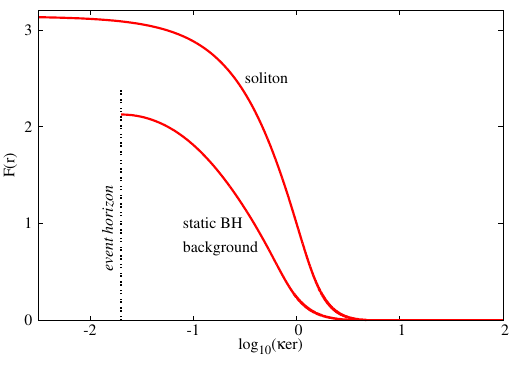
Figure 1 . The pro(cid:12)le of the Skyrme function, F ( r ), for the fundamental Minkowski and Schwarzschild Skyrmions. The mass term vanishes in both cases, m (cid:25) = 0, while r H (cid:20)e = 0 :